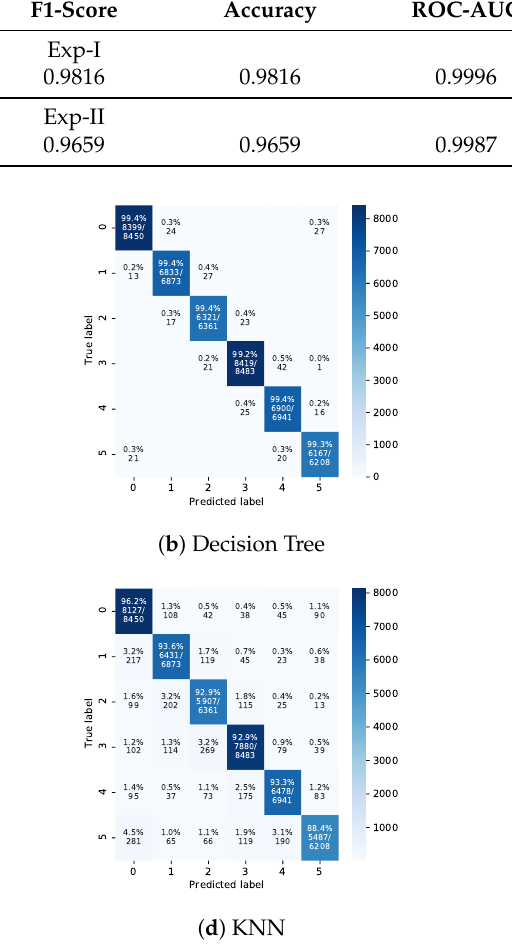
Table 2. Average handover prediction results for the gradient boosting model. Recall Precision F1-Score Accuracy ROC-AUC